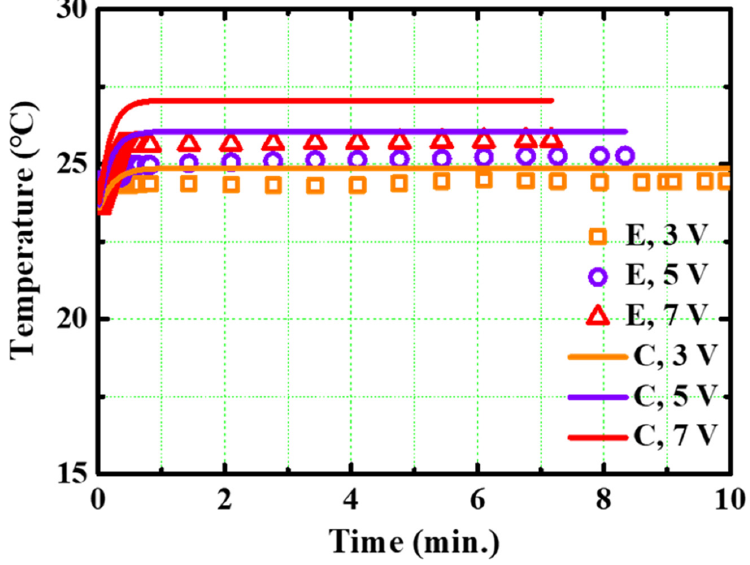
Figure 9. Comparison of the experimental and simulation results on the cathode temperature .